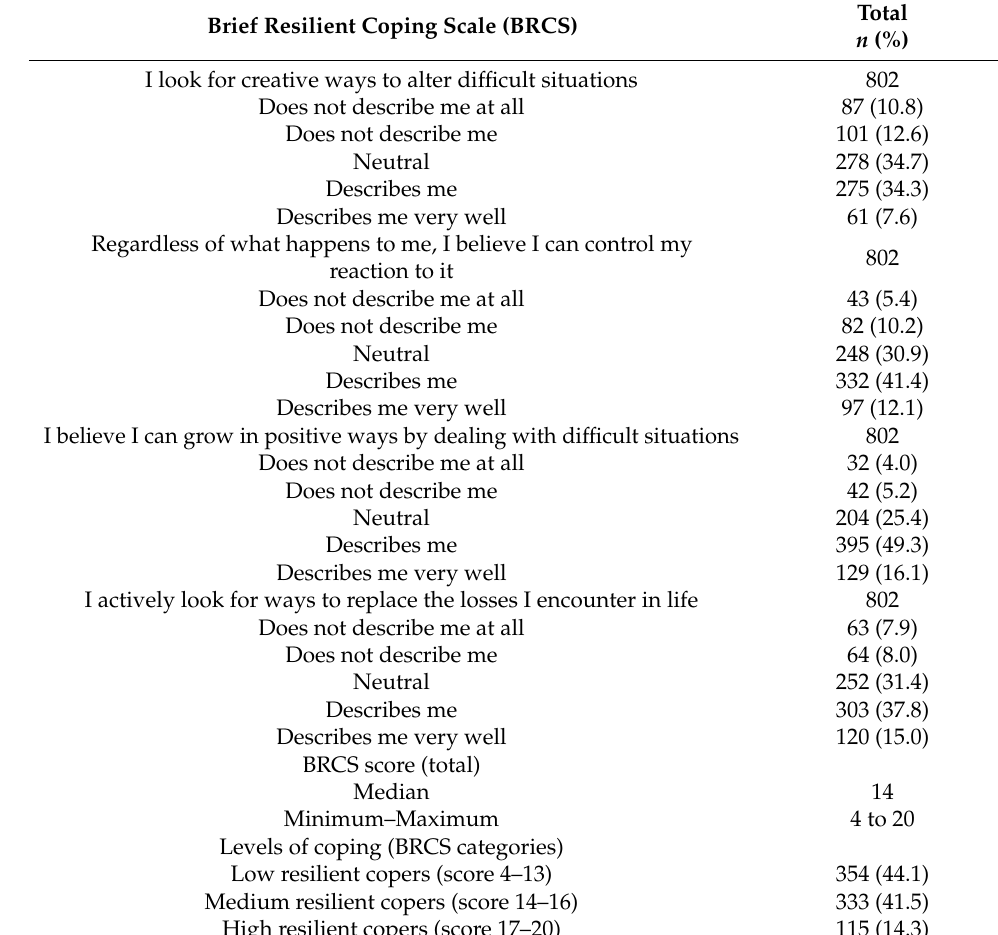
Table 6. Coping during the COVID-19 pandemic in Saudi Arabia.